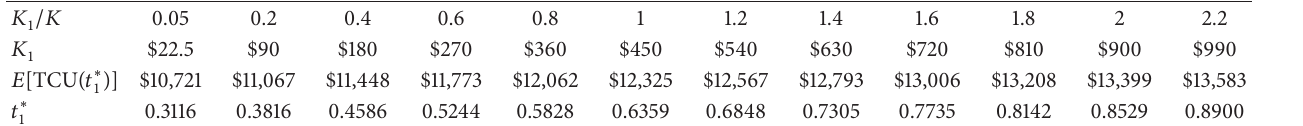
Table 2: Variations of the fixed delivery cost 𝐾 1 effects on the optimal production run time 𝑡 ∗ 1 .